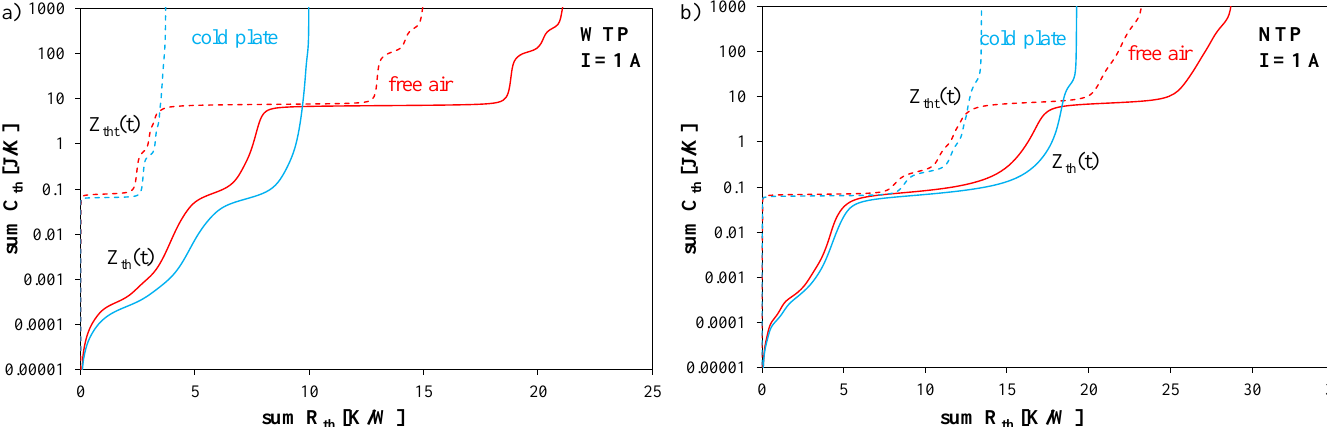
Figure 11. Structure functions determined using the MASTER program on the basis of the measured waveforms of self (solid lines) and transfer (dashed lines) transient thermal impedances of the diodes contained in the MCE device WTP ( a ) and NTP ( b ) measured with the T3Ster set-up.